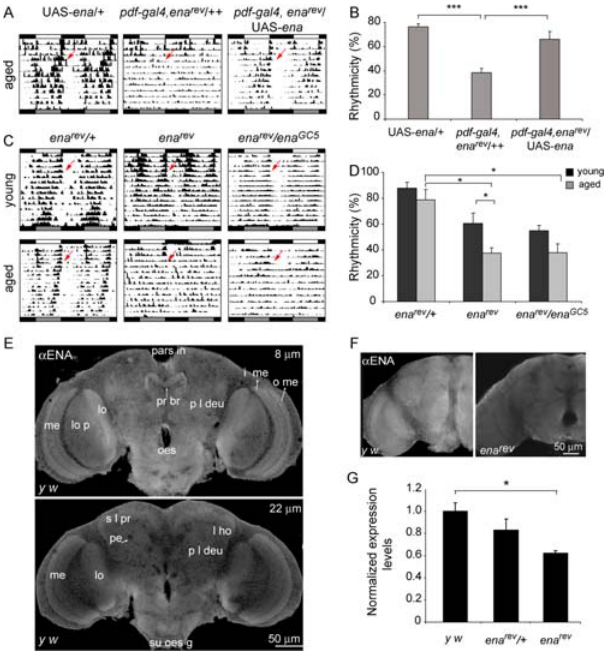
Figure 4. Age associated arrhythmicity is dependent on ena function. (A) Rescue of ENA function on the PDF circuit restores behavioral rhythmicity in aged flies. Recombinant pdf-gal4 , ena rev carrying one copy of UAS- ena were indistinguishable from control UAS- ena . Representative double plotted actograms for aged (24–28d) flies are shown. Overexpression of ENA in young flies do not affect locomotor activity rhythms (data not shown). (B) The percentage of rhythmicity for aged flies for each strain is shown. pdf-gal4 , ena rev / ++ is significantly different from both UAS- ena / + (control) and pdf-gal4 , ena rev /UAS- ena (*** p , 0.001). (C) Representative actograms of young (3d) and aged (21d) flies carrying one or two copies of ena rev , along with the transheterozygotes ena rev / ena GC5 . Both homozygous ena rev and ena rev / ena GC5 exhibit a decline on rhythm strength. (D) Summary of behavioral data for flies of the indicated genotypes. Control ena rev / + flies stay rhythmic throughout lifespan. Aged ena rev is significantly different from its younger counterpart (* p , 0.05). Both aged ena rev and ena rev / ena GC5 are different from old ena rev / + (* p , 0.05). Experiments summarized in B and D were repeated at least 3 times. (E) Whole mount brain immunofluorescense of 10 day-old adult y w flies were stained with a specific antibody against ENA. A general staining of neuropils in the adult brain was observed. Single confocal planes (2 m m thick) are shown at two depths (8 and 22 m m) to highlight different brain areas. Some of the neuropils labeled with ENA are the outer (o me) and inner medulla (i me), lobula (lo) and lobula plate (lo p) within the optic lobe, the protocerebral bridge (pr br) in the central complex as well as other regions in the protocerebrum such as the lateral horn (l ho). Other structures, as the protolateral deutocerebrum (p l deu), superior lateral protocerebrum (s l pr), the peduncles of the mushroom body (pe), pars intercerebralis (pars in), suboesophageal ganglion (su oes g) and oesophagus (oes) are also shown in the figure. (F) ena levels are reduced in ena rev mutants compared to the control y w . Images were taken with the same confocal settings for direct comparison; projections of 2.3 m m depth are shown. ENA immunohistochemistry was repeated at least three times. (G) RT-PCR analysis was performed in adult ena rev , ena rev / + and control total RNA. The ratio between ena and actin expression levels for each genotype is shown. Quantification of RNA levels showed significant changes in ena rev homozygous (* p , 0.05) whereas a minor (non significant) decrease was seen in ena rev / + heterozygous when compared to the y w control line. The experiment was repeated three times employing independent RNA